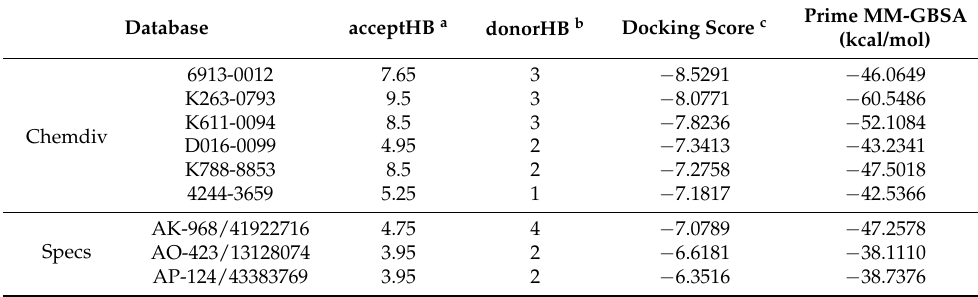
Table 1. Information of nine selected compounds.